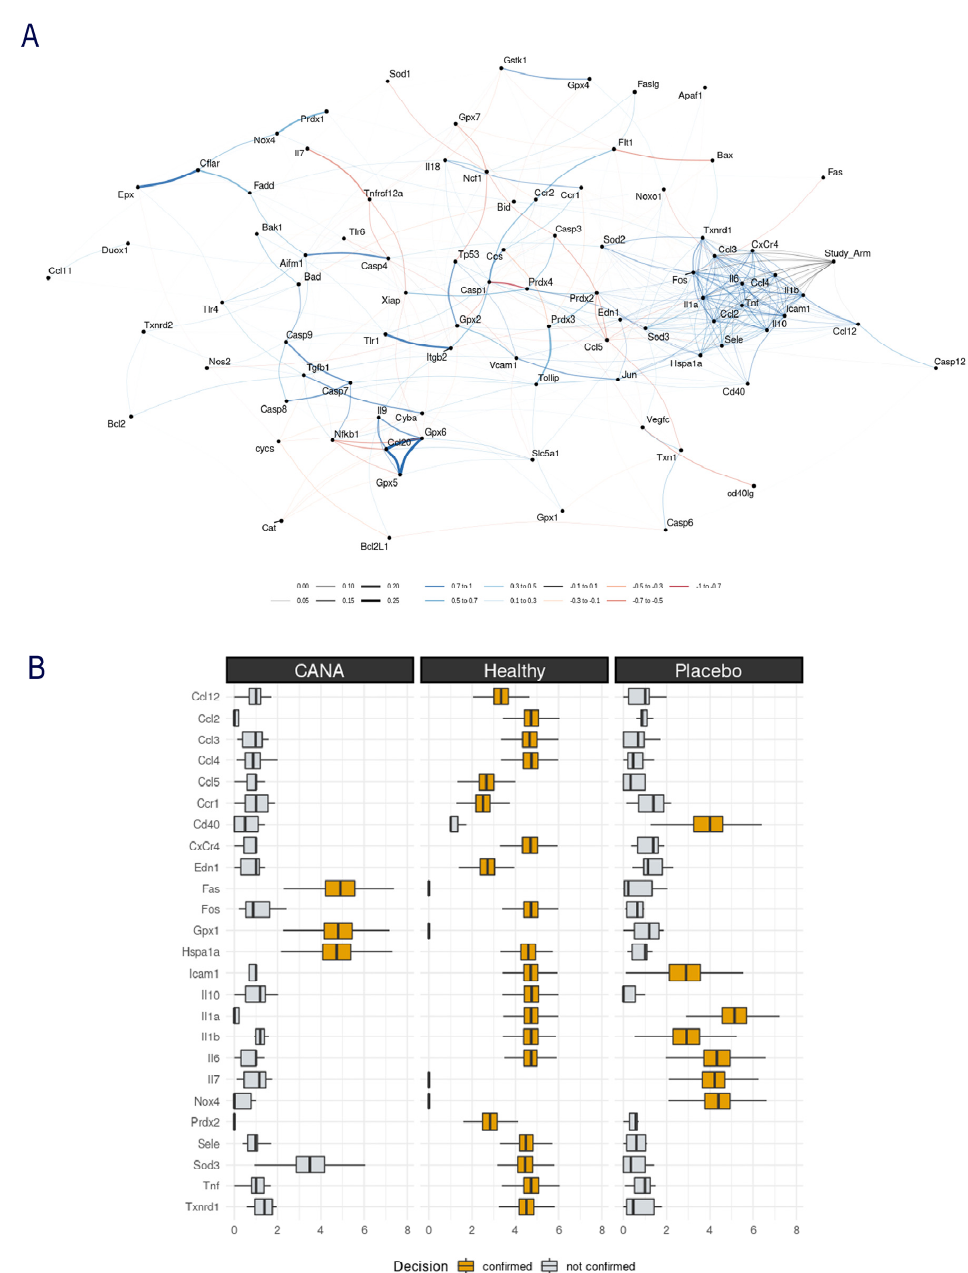
Figure 3. Machine-learning analysis: ( A ) Gene correlation network: a node represents each investigated gene. The closeness between nodes and the connection width are proportional to the random-forest variable importance. The colors indicate the Spearman’s coefficients: blue or red lines are associated with a positive or negative correlation, respectively. The grey connections are random-forest patterns without a significant Spearman coefficient. “Study arm” is the group variable: Control/IR/IR + CANA. This node is connected (right side of the network), with a cluster of genes, including Txnrd1 , Ccl3 , CxCr4 , Il6 , Ccl4 , Il1b , Tnf , Ccl2 , Il10 , IL1a , Fos , Sod3 , Hspa1a , Cd40 , Ccl12 and Icam1 . These genes are in a significant positive Spearman correlation with each other. In contrast, the other tested genes do not show a cluster pattern. ( B ) Genes predicting the experimental group (Control, IR, or IR + CANA). The genes identified with the yellow horizontal box plots respond to the question: “is this IR + CANA or not?”, “is this Control or not?”, “is this IR or not?”. The Y -axis depicts genes (abbreviations are defined in Table 1) and the horizontal axis indicates the predictive power of a gene for the group identification, as calculated by the random forest model. IR indicates ischemia/reperfusion, CANA